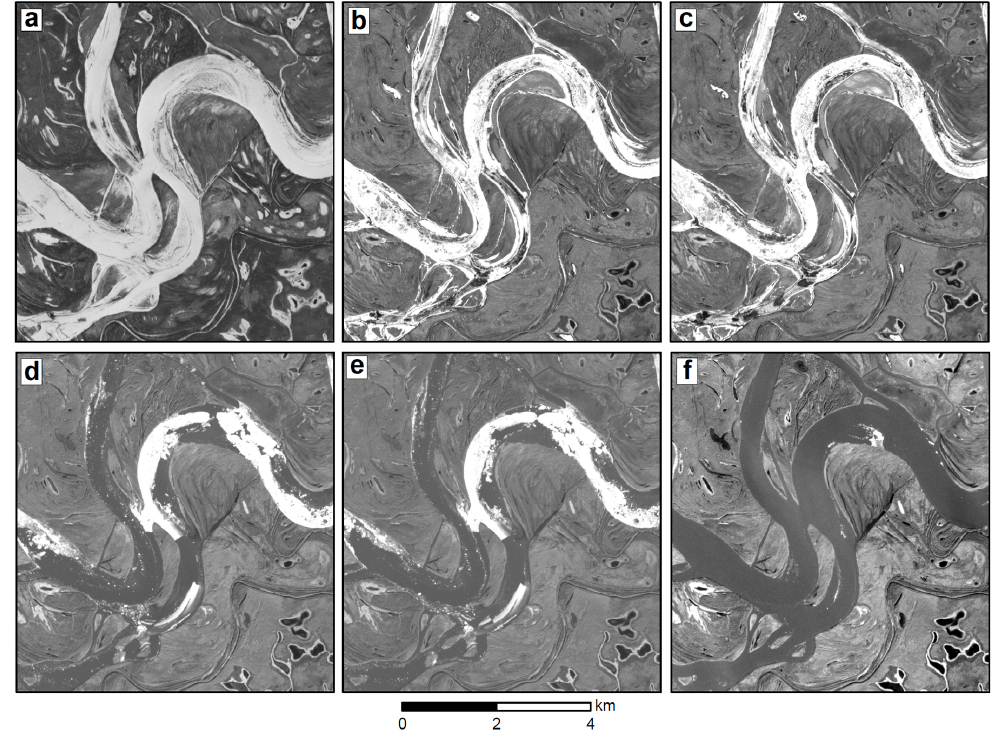
Figure 12. Time series of river ice breakup on the Yukon shown in the near infrared band of PlanetScope imagery. Panels show ( a ) 2 May, ( b ) 6 May, ( c ) 7 May, ( d ) 12 May, ( e ) 12 May (7 min later) and ( f ) 15 May.